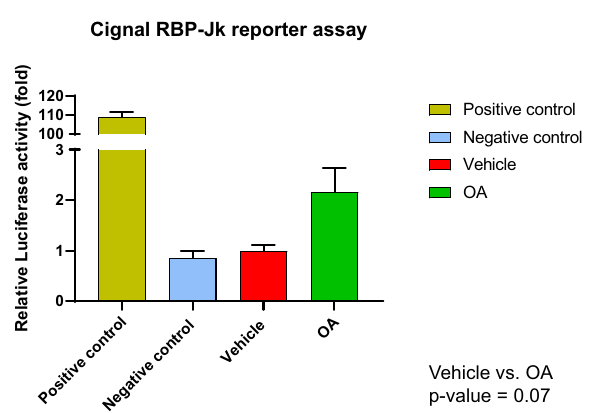
Fig. 5 Effects of OA on Notch signaling. NOTCH transcriptional activity was measured using the Cignal RBP-Jk reporter assay following exposure of MCF-10A cells to 5 mM octanoic acid (OA) for 24 h. Luciferase levels were normalized to Renilla luciferase. The results were plotted as fold change with respect to the untreated. ( n = 3, mean ± SEM). The p -value was calculated by unpaired